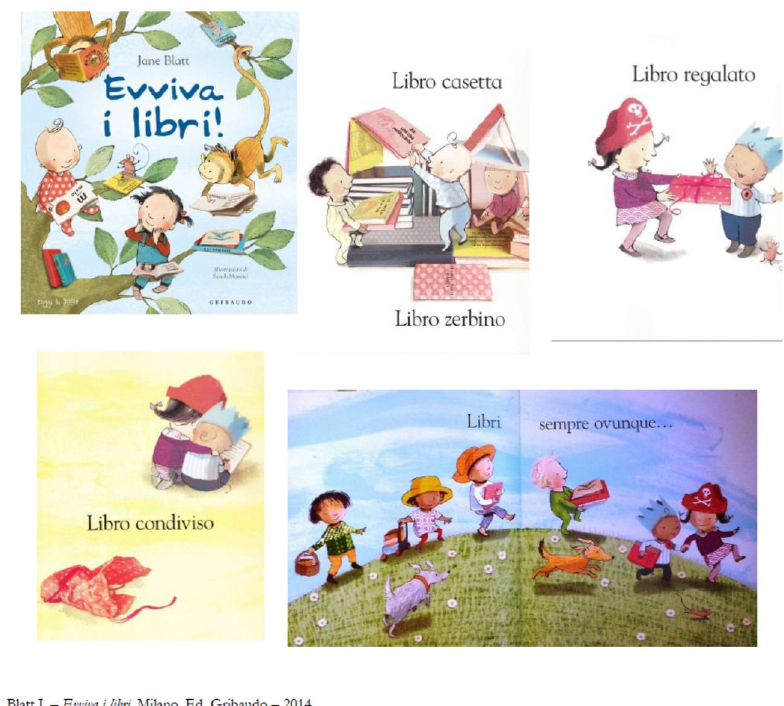
Figure A3. Blatt J.— Evviva i libri. Milano, Ed.